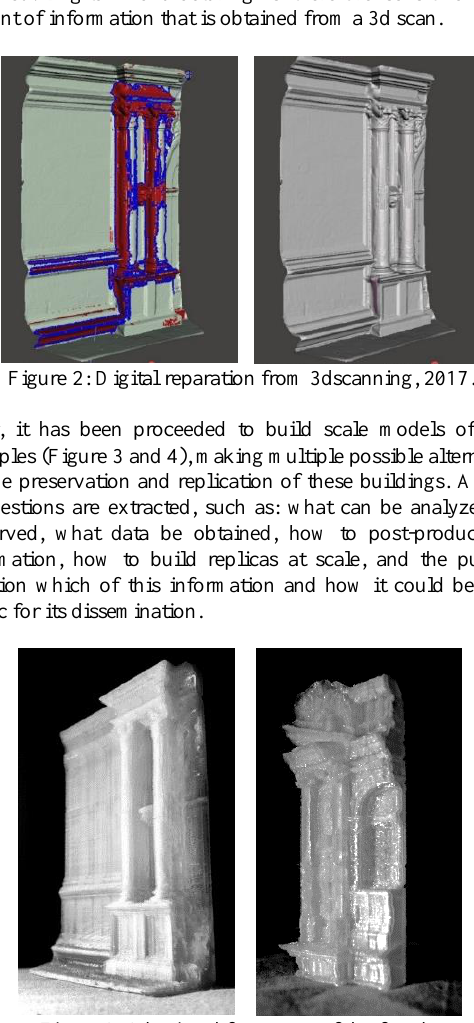
Figure 3: 3d printed fragments of the façade. FDM print in PETG plastic, 2017.